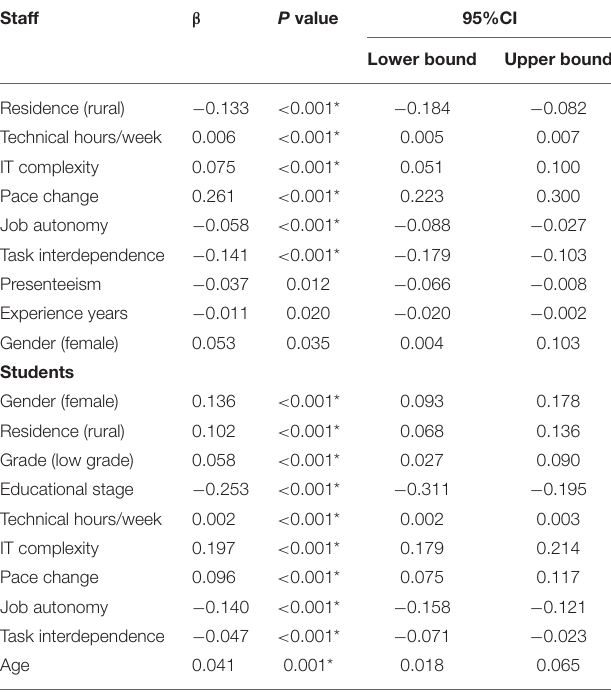
TABLE 3 | Risk factors for technostress among staff and